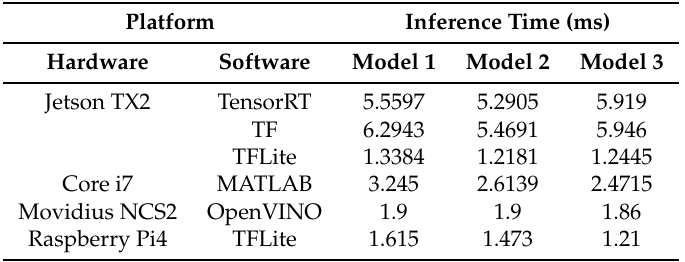
Table 3. Comparison of the inference time between models.